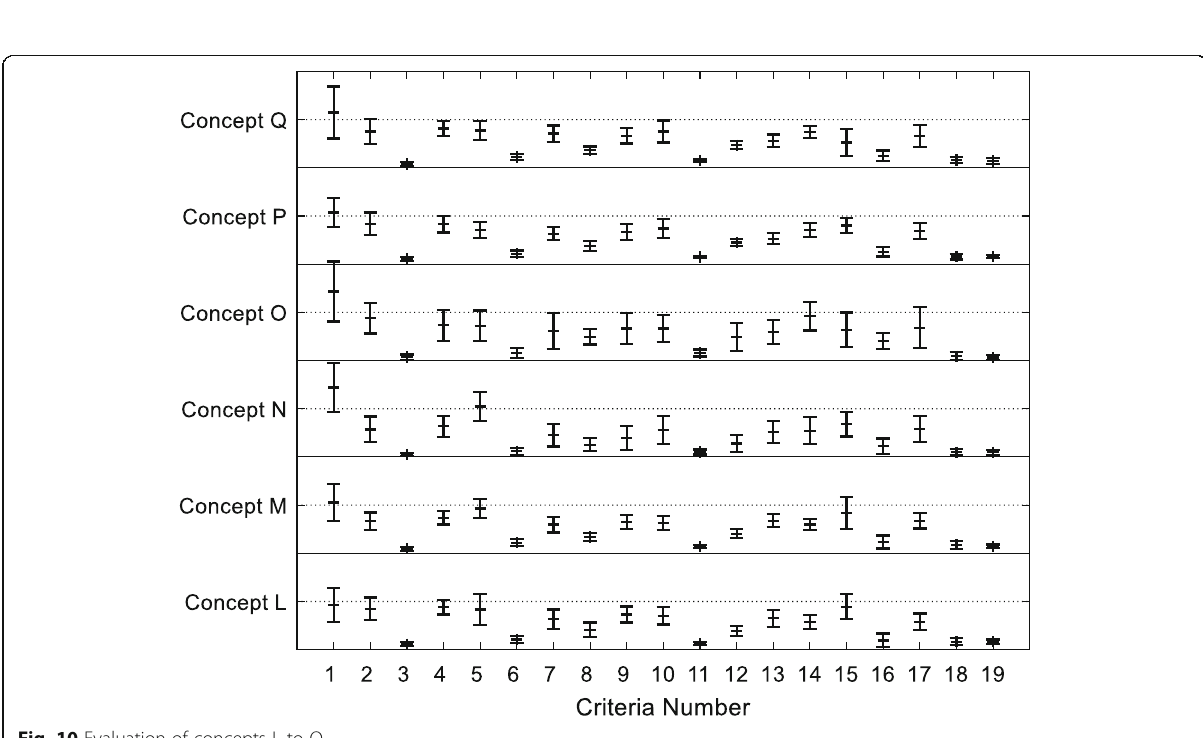
Fig. 9 Evaluation of concepts F to K